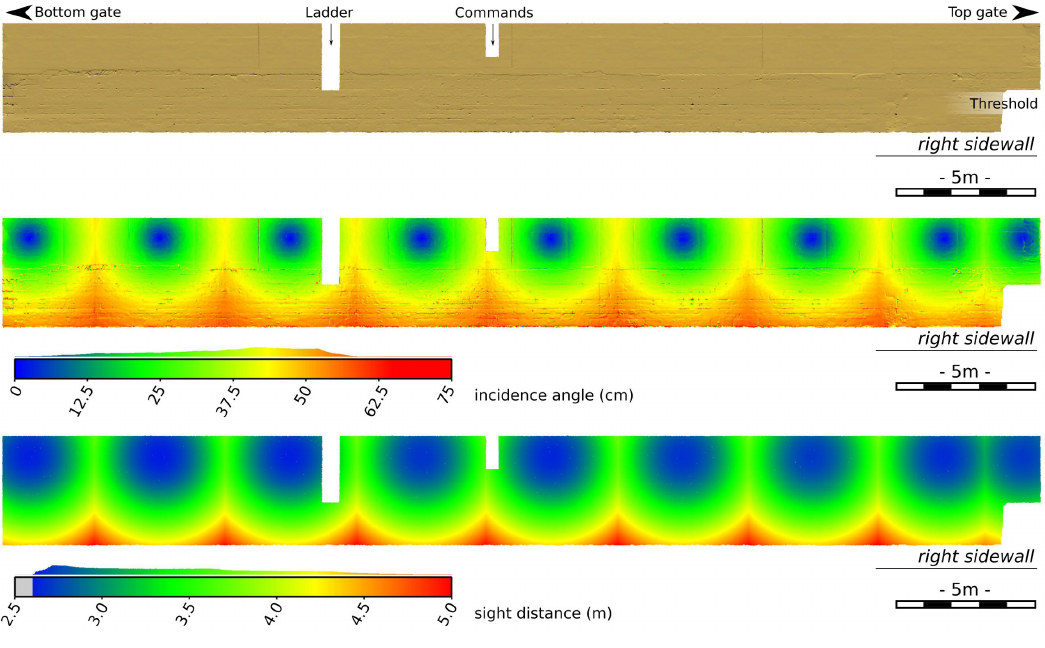
Figure 3. (Top) TLS mesh of the right sidewall of the chamber (reference): the two indentations correspond to a ladder and to a groove used for the lock paddle commands, the threshold is visible on the right; (middle) incidence angles; (bottom) sight